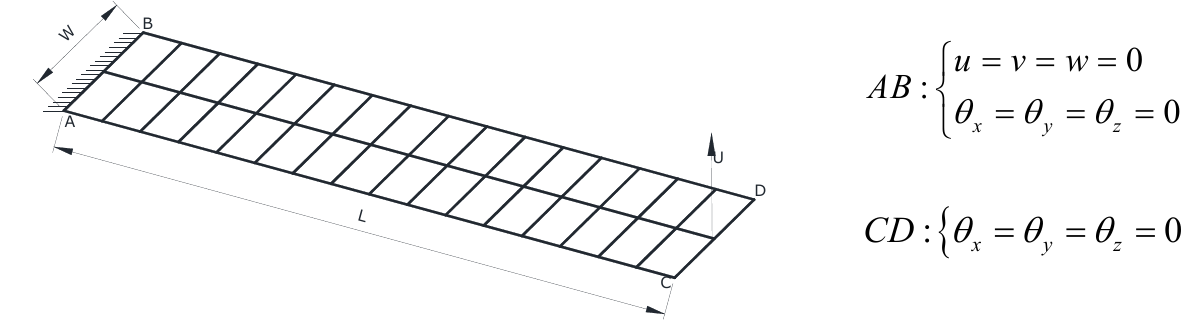
Figure 6. Finite element model and boundary conditions.